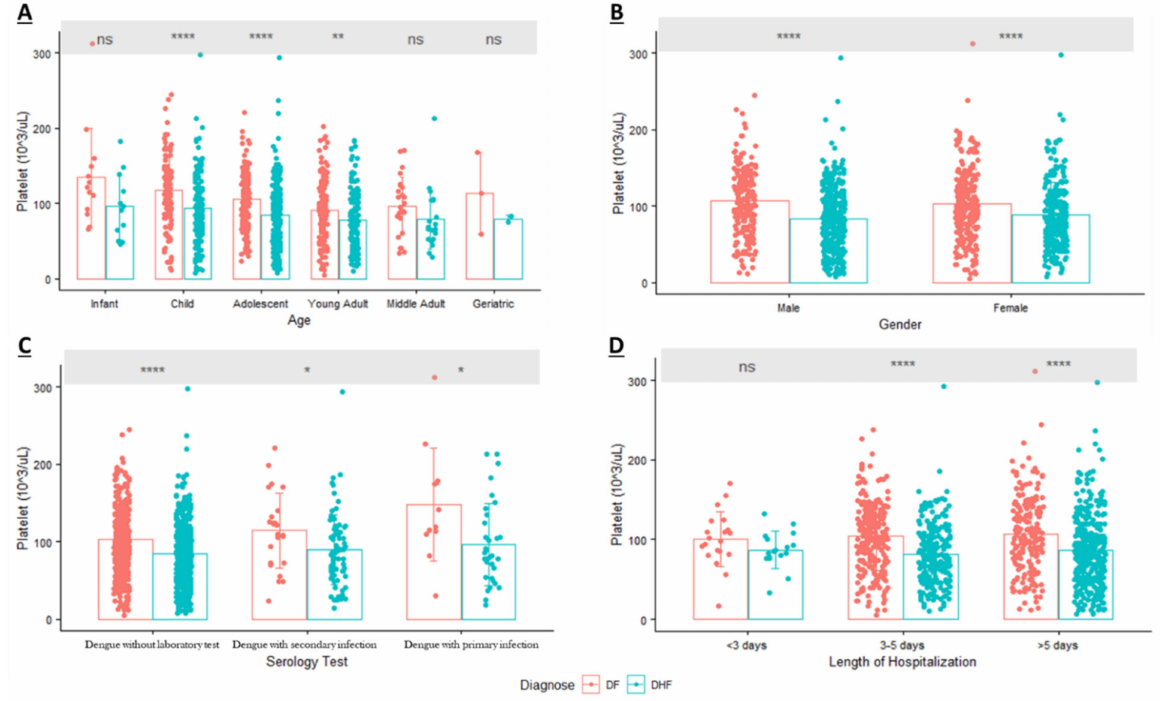
Figure 2. Distribution of Platelet (mean ± SD) in Dengue Patients based on: ( A ). Age; ( B ). Gender; ( C ). Serology Test; ( D ). Length of Hospitalization (ns = Non Significant; * p -value < 0.05; ** p -value < 0.01; **** p -value < 0.0001; DF: Dengue Fever; DHF: Dengue Hemorrhagic